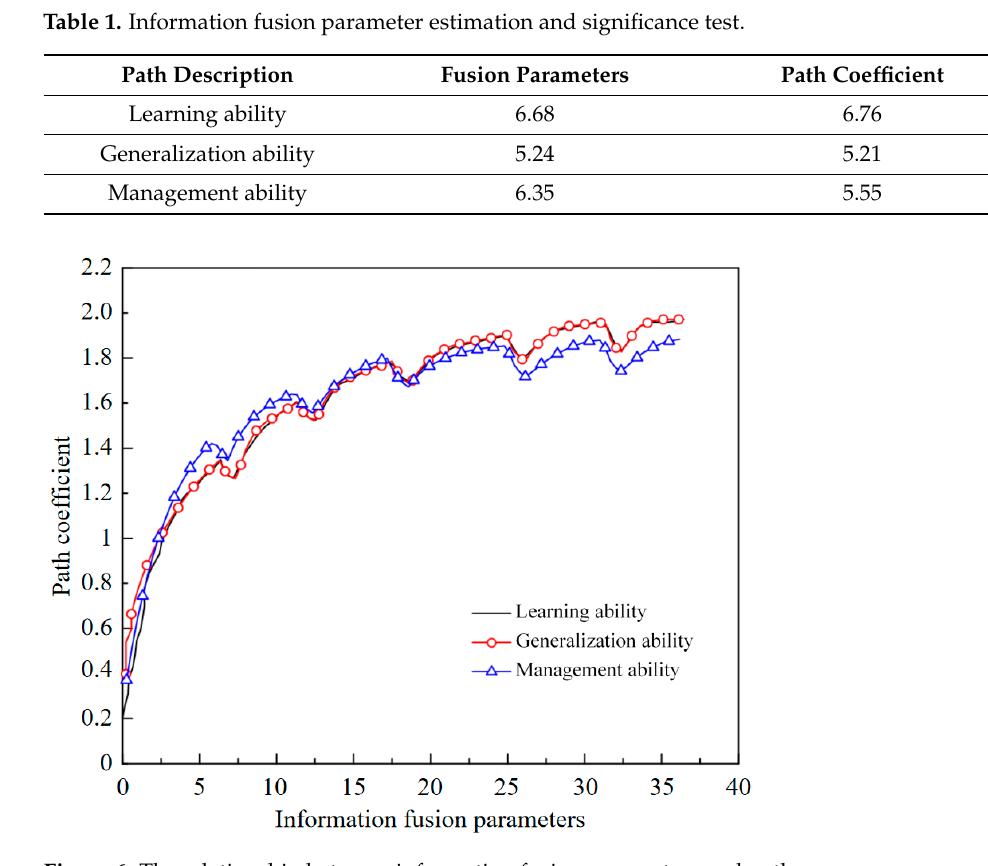
Figure 6. The relationship between information fusion parameters and paths.